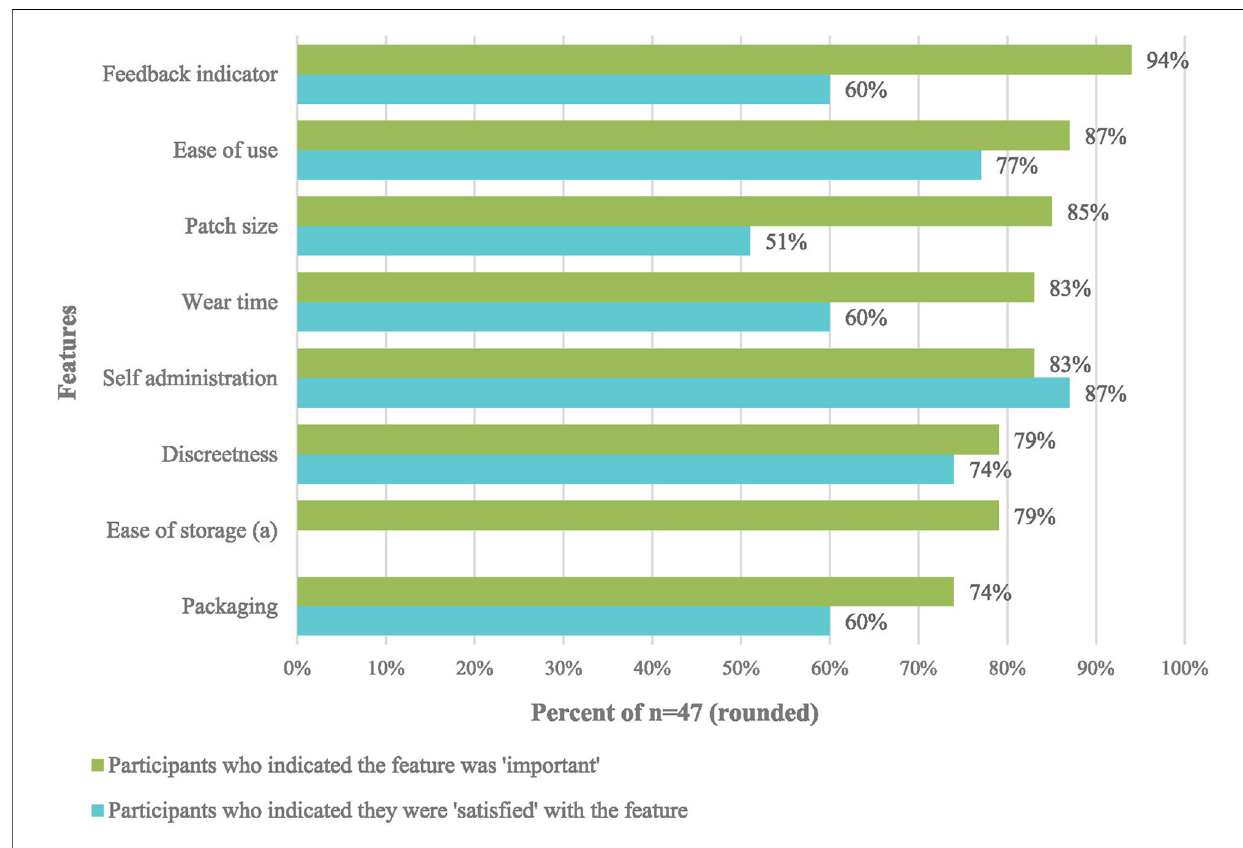
FIGURE 3 Differences between “ important ” and “ satis fi ed ” for MAP features after mock use by AGYW, FSW, MSM, and health service providers ( n